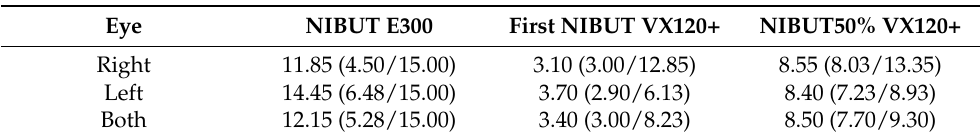
Table 1. Non-invasive tear break-up time (NIBUT) obtained from Medmont E300 and Visionix VX120+ devices.